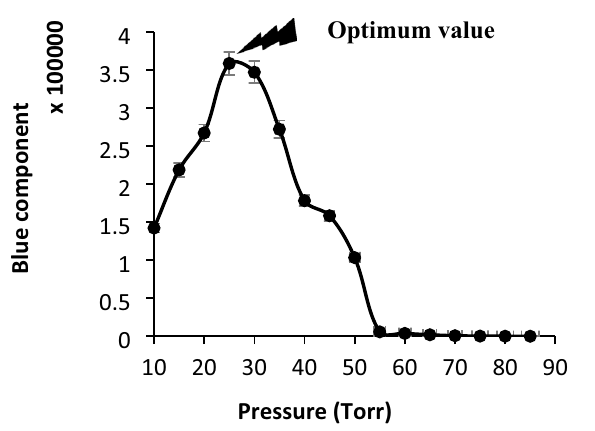
Figure 6. Effect of pressure on the sensitivity of the humidity optical sensor. Conditions: length of filament 6.00 ± 0.01 mm, RH: 40–45%, applied voltage: 110 ± 1 V (AC, vs. GND) and temperature 40–45 °C. The data are the average of three independent analyses. Error bar: ± relative standard deviation.